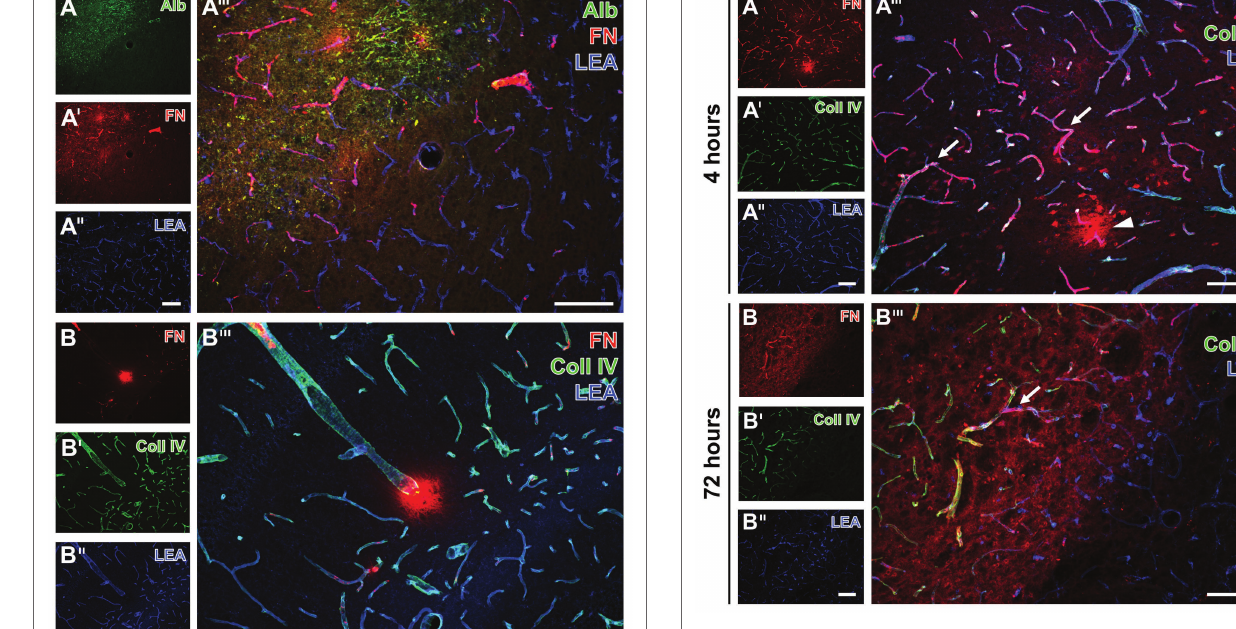
FIGURE 2 | Fluorescence-based detection of collagen IV and fibronectin combined with vessel staining in mice subjected to 4 and 72 h of experimental focal cerebral ischemia. Increased immunosignals of fibronectin (FN) and collagen IV (Coll IV) are visible at both 4 (A) and 72 h (B) of ischemia in affected areas. At both time points, FN consistently appears associated with the vasculature (arrows in A ''' and B ''' ) and in a diffuse manner with focal accumulations (arrow head in A ''' ) in close vicinity to vessels. Concomitantly, increased Coll IV immunosignals precisely demarcate the area of ischemic affection (B ' ) , which becomes even clearer when merging the staining patterns of FN and Coll IV (B ''' ) . Thereby, overlapping signals of FN and Coll IV becomes visible by the purple color (A ''' ,B ''' ) . Lectin-based counterstaining using LEA visualizes the vasculature also in ischemic areas (A '' ,B '' ) . Scale bars: in A ''' and B ''' = 100 μ m, in A '' (also valid for A and A ' ) and B '' (also valid for B and B ' ) = 100 μ m.